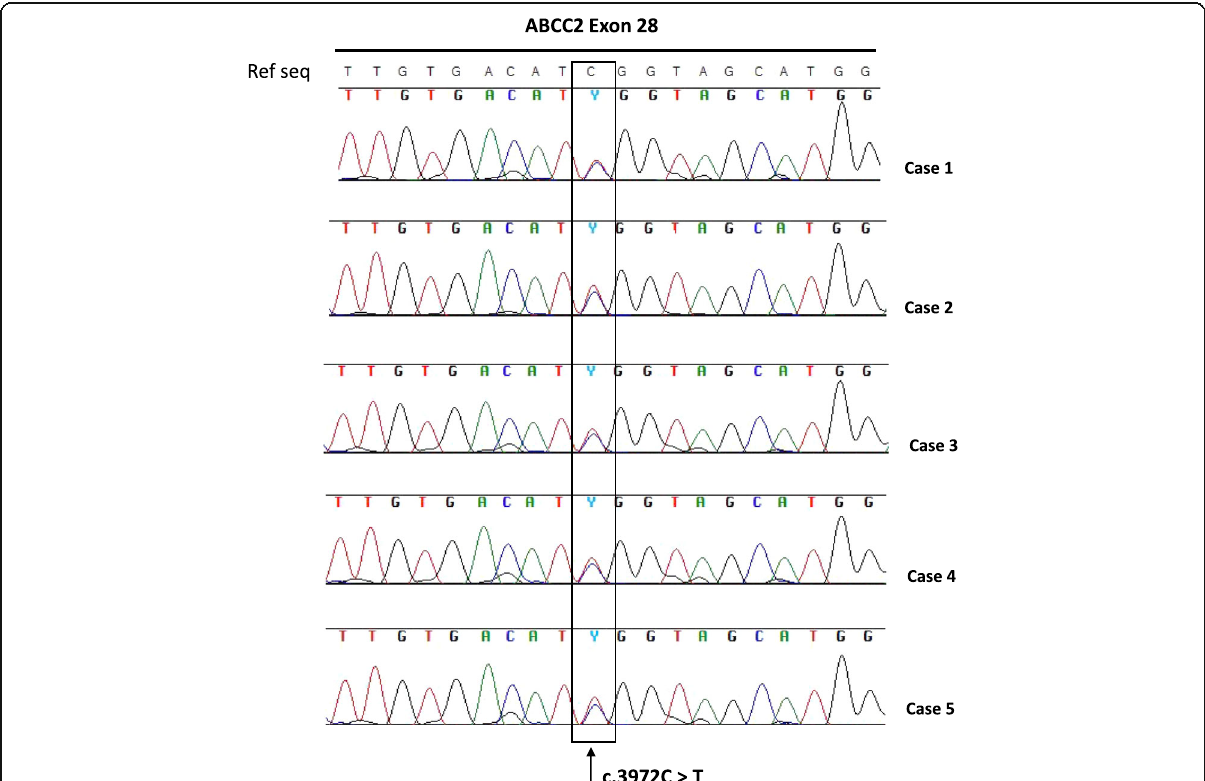
Fig. 1 DNA Sanger sequencing from the peripheral blood lymphocytes of the five siblings (Cases 1 – 5), showing the presence of c.3972C> T SNP at exon 28 of ABCC2 gene in all the samples. SNP: single nucleotide polymorphism; Ref Seq: reference